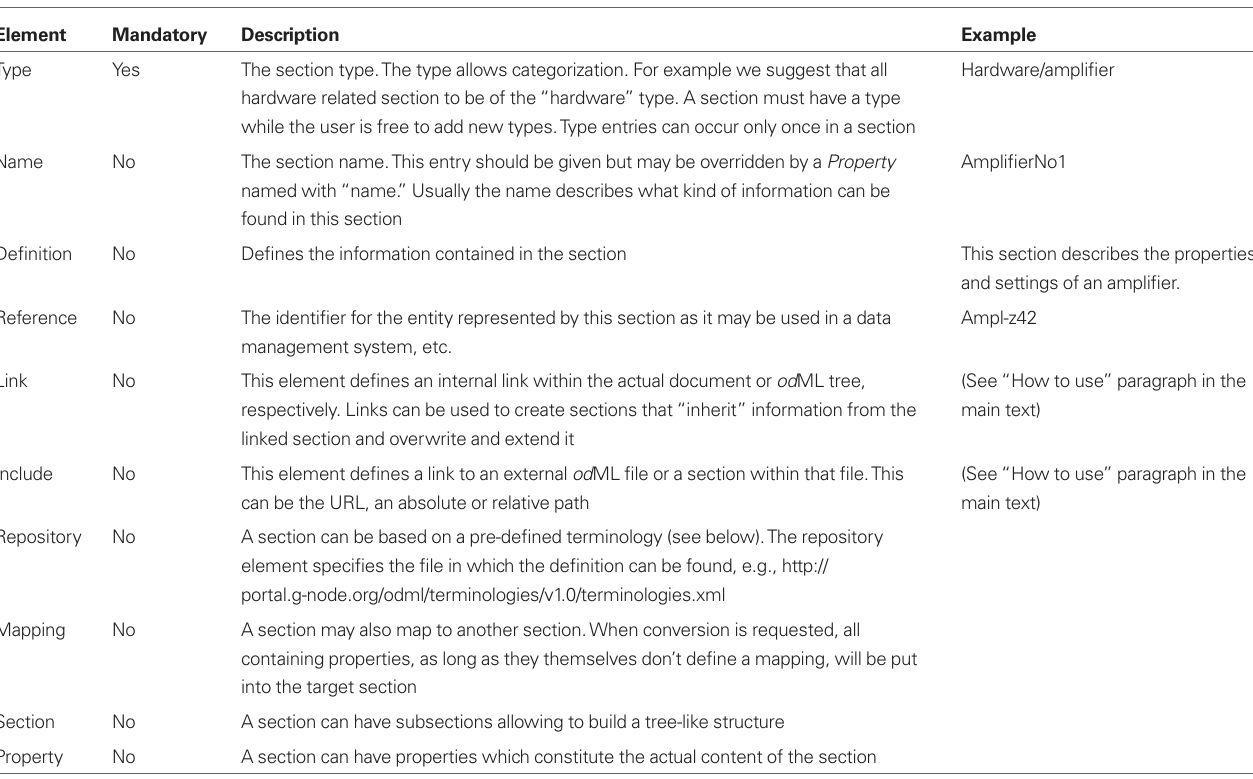
Table A2 | Open metaData Markup Language section.